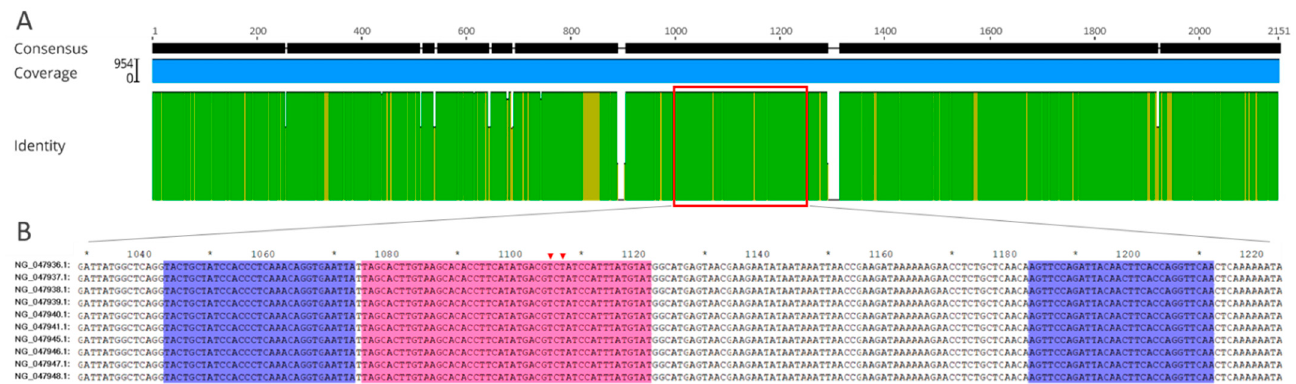
Figure 1. Design of the mecA real ‐ time RAA primers and probe. ( A ) Schematic diagram showing the conserved region of the mecA gene by a multiple sequence alignment. The full ‐ length mecA genes of 954 strains of MRSA were aligned using the Geneious Prime software; a conserved region (p. 1041–1210) was selected as the final target for the RAA assay is marked with a red box. ( B ) Positions of the mecA real ‐ time RAA primers and probe. The specific positions of the RAA probes and primers are shown on the mecA gene sequences of 10 representative MRSA strains with the GenBank accession numbers on the left side. The forward primer (F1041–1071), reverse primer (R1181–1210), and exo probe (p1073–1120) are marked with blue, blue, and pink shading, respectively. The two conserved thymine (T1103, T1105) residues labeled with dT-fluorophore residue (FAM-dT) and dT-quencher residue (BHQ1-dT) within the probe are marked with solid pink triangles,